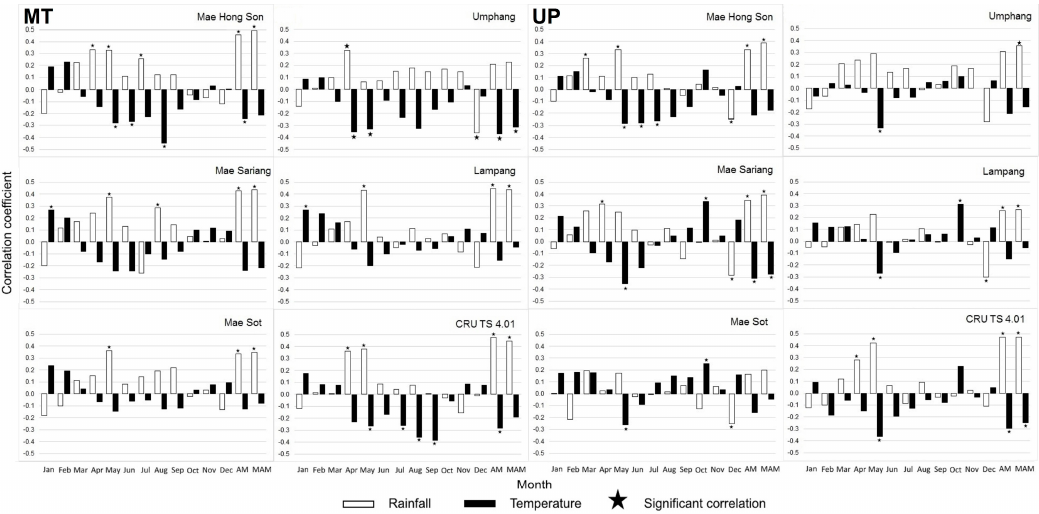
Figure 4. Correlations between tree-ring chronology and some climatic data (rainfall (white vertical bars) and temperature (black vertical bars)) from five meteorological stations in northwestern Thailand and the CRU TS 4.01 data set (1951–2016) at the 95% significance confidence level. Table 4. Correlation coefficients between tree-ring data and rainfall and temperature.